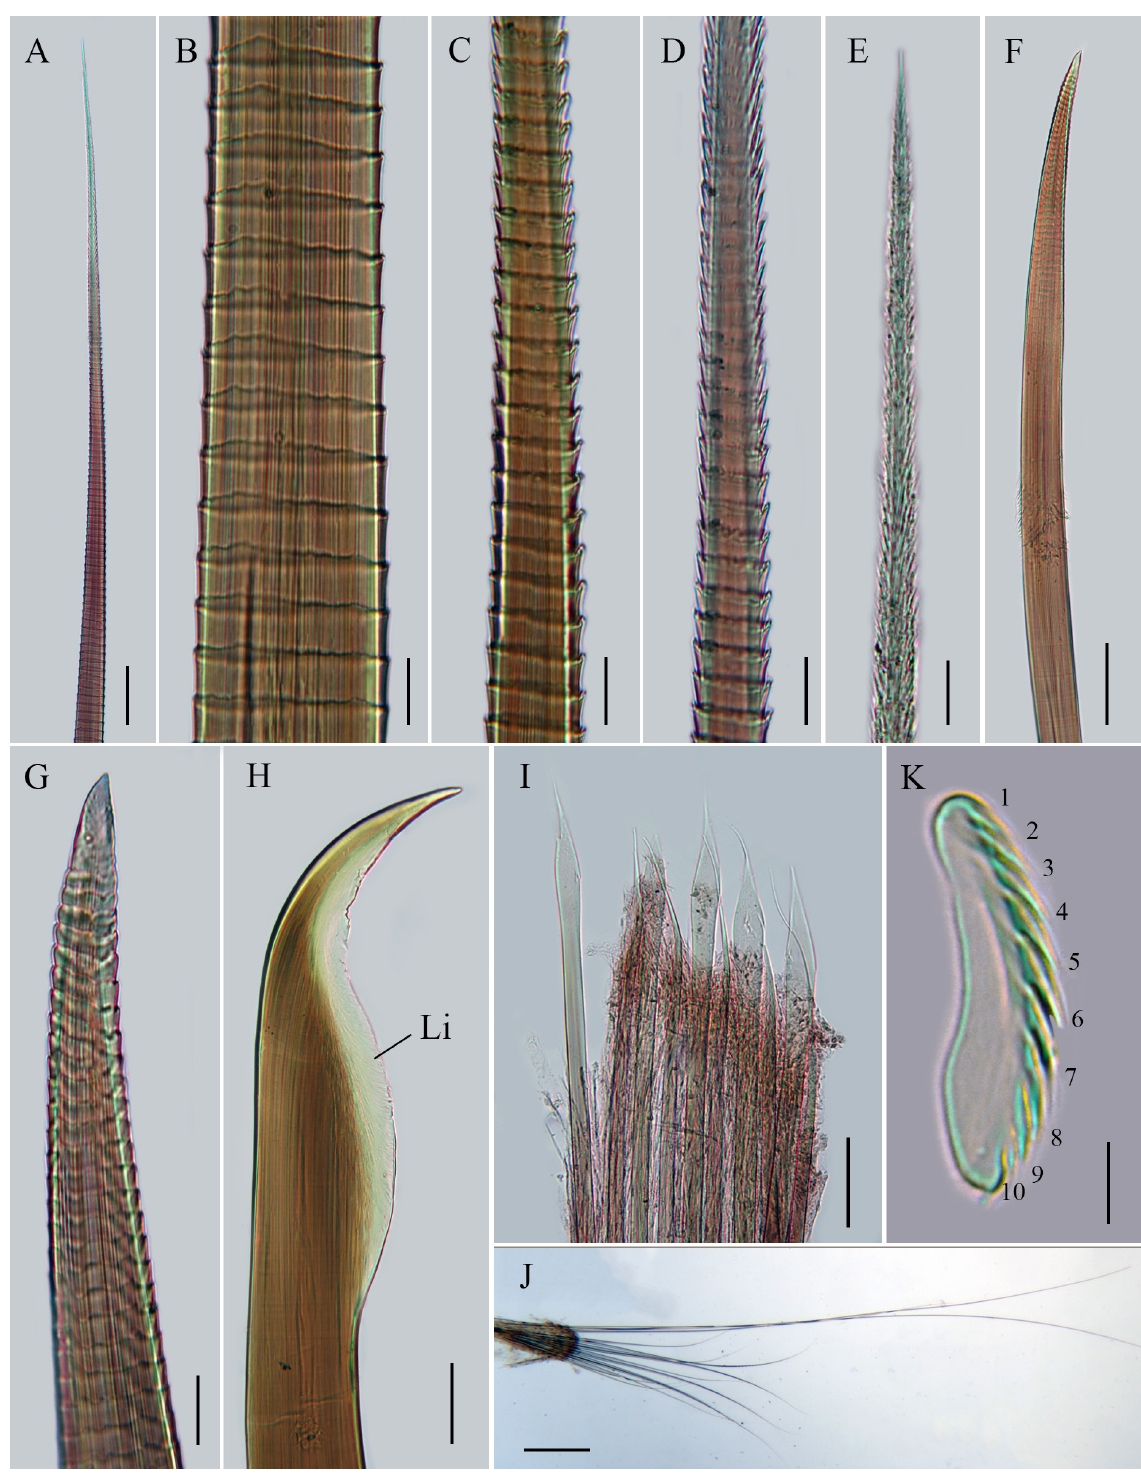
Fig. 6. Phalacrostemma danieli sp. nov., holotype (UMML-22.1179). A . Outer palea. B . Proximal region outer palea. C . Middle region of outer palea. D . Middle-distal region of outer palea. E . Tip of outer palea. F . Inner palea. G . Tip of inner palea. H . Nuchal hook. I . Parathoracic notochaetae. J . Abdominal parapodium. K . Uncini. Abbreviation: Li = limbation. Numbers indicate the rows of teeth. Scale bars: A, F, H–I = 100 µm; B–E, G = 20 µm; J = 200 µm; K = 10